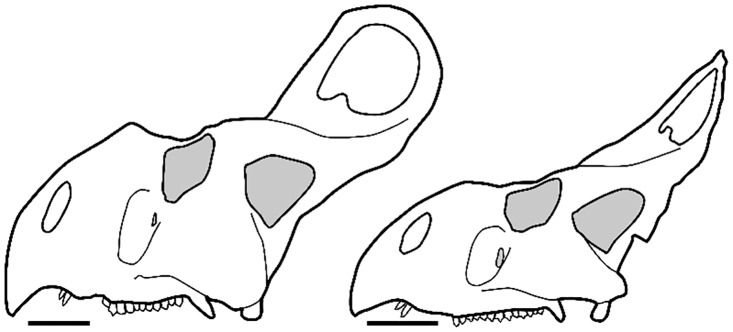
Hypothetical large “male” at left (AMNH 6438) and hypothetical large “female” at right (AMNH 6466).Redrawn and modified after Brown and Schlaikjer [23]. Scale equals to 10 cm.